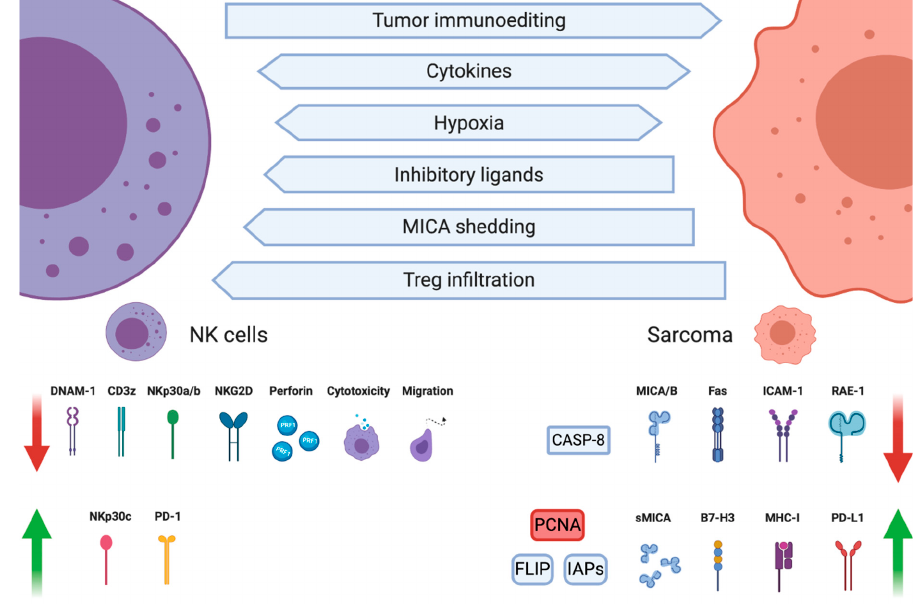
Figure 2. Interactions between natural killer (NK) cells, cancer cells, and tumor microenvironment (TME) shape sarcomas’ immunoevasion mechanisms. Tumor immunoediting, cytokines, hypoxia, and cells infiltrating the TME can change the sarcomas cell phenotype into an NK cell-resistant one,